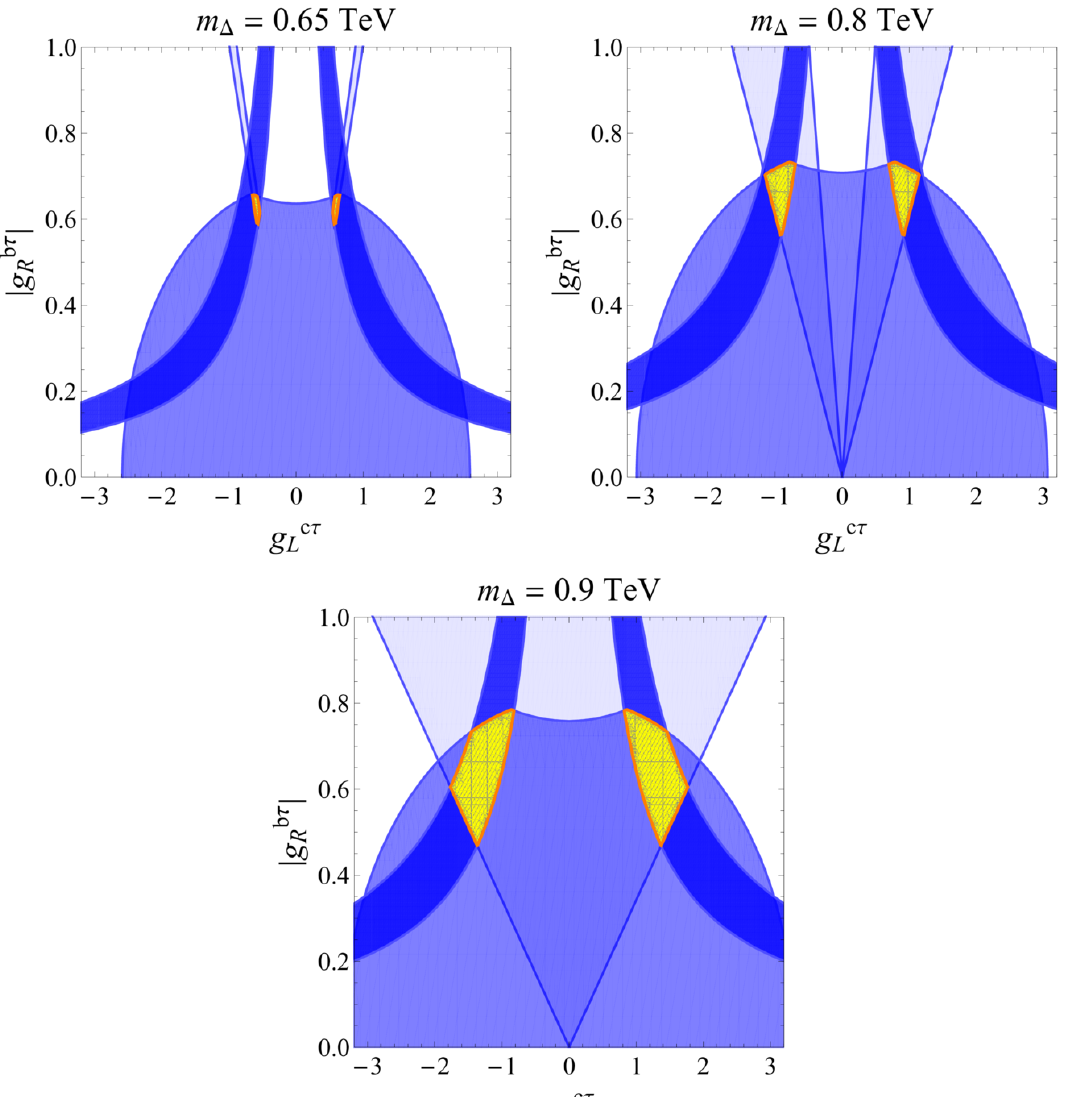
Figure 5 . The allowed region on the plane g c(cid:28) g b(cid:28) by current experimental constraints is shown L (cid:2)j R j in yellow for m (cid:1) 0 : 65 ; 0 : 8 ; 0 : 9 TeV. We assume g b(cid:28) to be a purely imaginary coupling, as R 2 f g described in the text. The separate allowed regions both from the direct searches at the LHC, the Z -pole observables and R D are shown from lighter to darker blue, respectively. Thus, the yellow region is given by their intersection. See text for details.